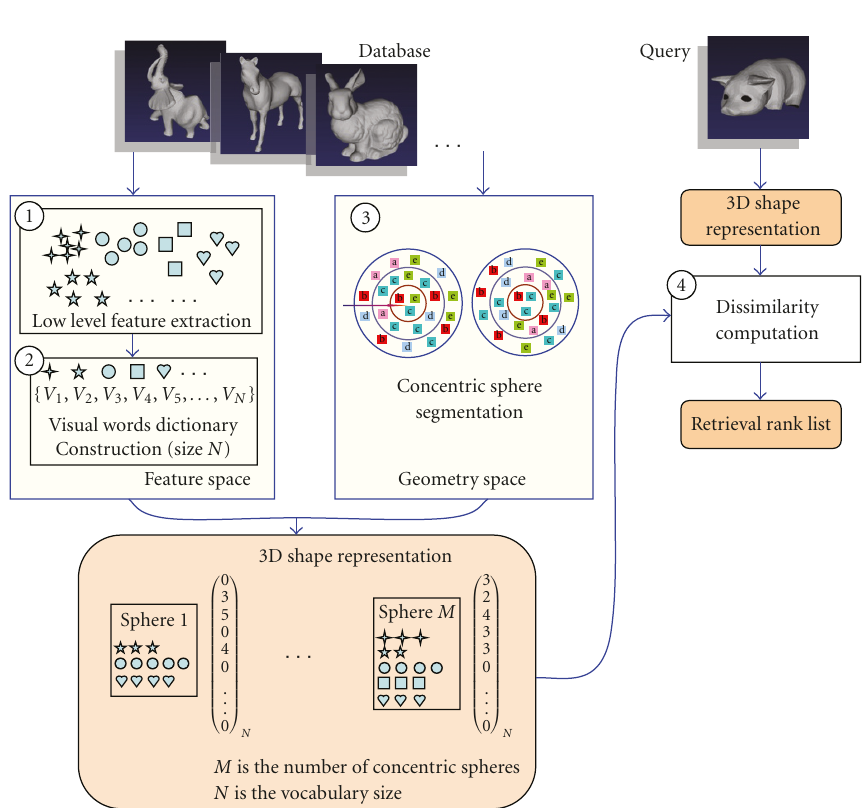
Figure 2: A schematic description of CBW